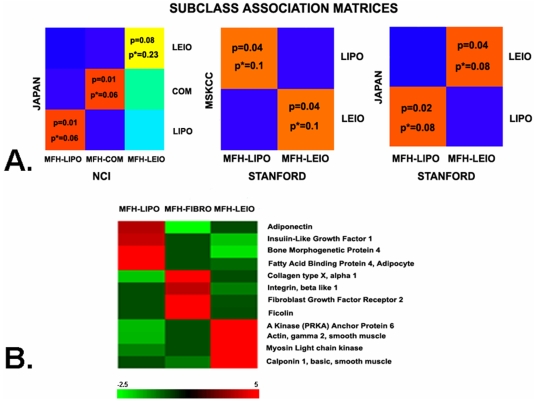
Reclassified MFH samples correspond to their respective STS subtypes across different datasets and express the tissue specific markers of their respective STS subtypes.
A) Subclass Association Matrices assessing molecular correspondence of reclassified MFH samples across different datasets:
Left: NCI versus Japan dataset (COM: composite MPNST-SYN group). Center
: Stanford versus MSKCC dataset. Right: Stanford versus Japan dataset. In all cases p* is Bonferroni-corrected. (Color scale: Red and Yellow colors indicate p<0.05 and 0.05≤p<0.1, respectively suggesting strong molecular correspondence between subtypes in different datasets. Other colors indicate p>0.1 suggesting lack of molecular correspondence). Details are provided in Table S5). B) Expression of tissue specific markers in MFH samples: Heat map showing upregulation of selected genes associated with smooth muscle, fibroblast and adipocyte differentiation (based on Gene Ontology or literature) in MFH tumors predicted as leio-, lipo-, or fibrosarcoma, respectively, compared to the rest of MFH tumors (t-test p<0.05). Color scale (saturated at 5-fold upregulation) indicates average fold change for each predicted MFH subclass compared to the rest of MFH tumors. Detailed fold changes are provided in Figure S3.